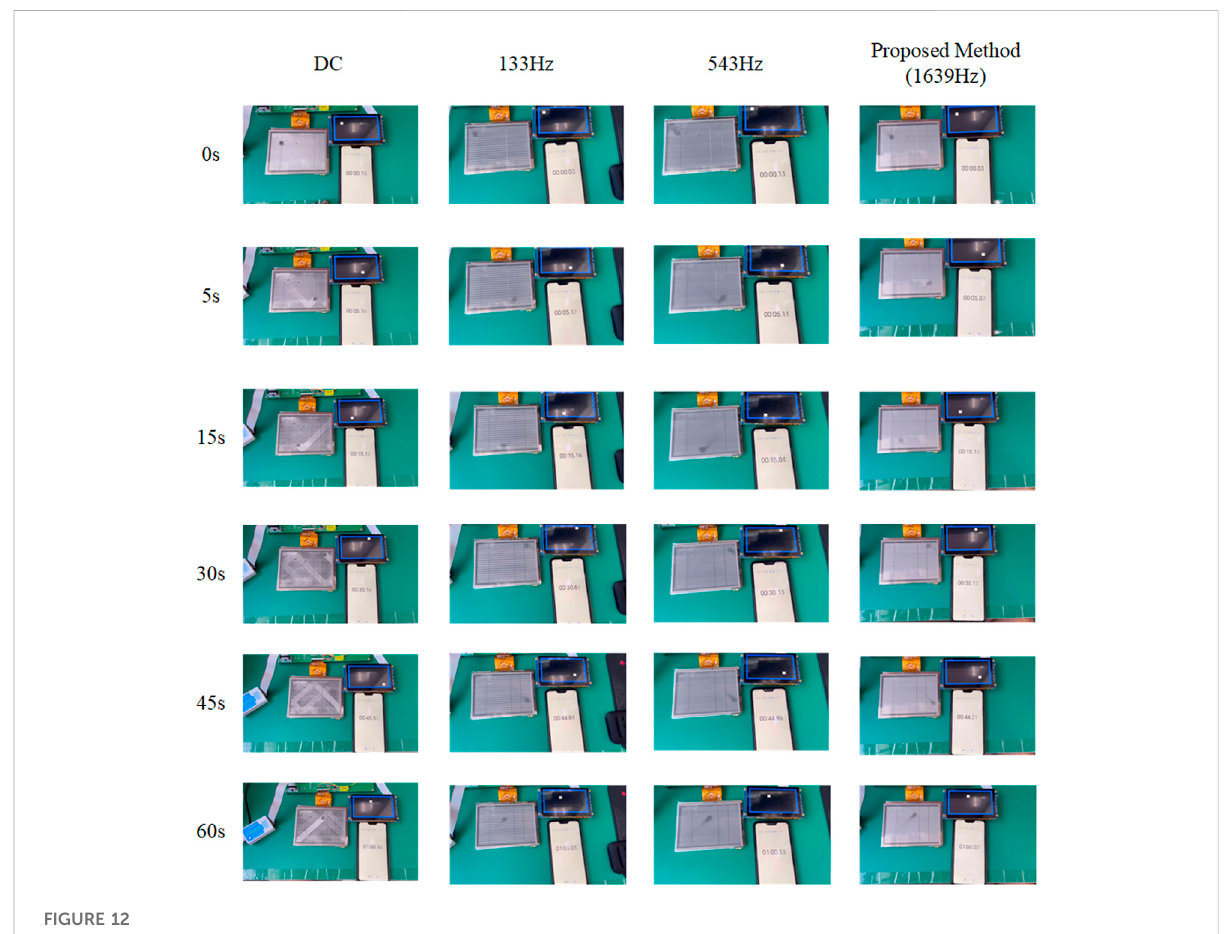
FIGURE 12 Asymmetric AC driving results at different